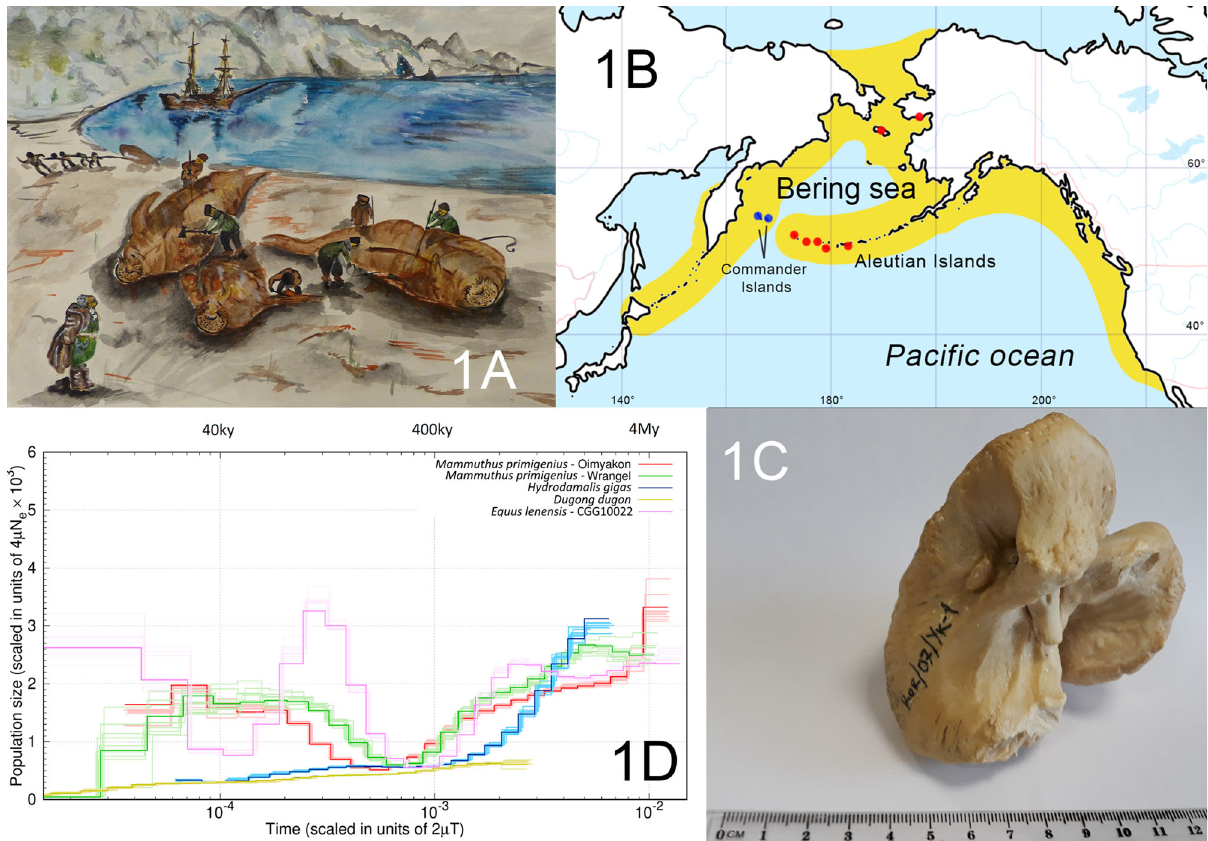
Fig. 1 Genome sequencing of the extinct Steller ’ s sea cow. A Reconstruction, aquarelle: The sailors of the Vitus Bering ’ s Great Northern Expedition (1741) cutting up the carcasses of killed Steller ’ s sea cows. Artist: Ekaterina Khritonenkova. B Geographical map of the Bering Sea region showing the distribution range of Steller ’ s sea cow during the Late Pleistocene (yellow), the archeological sites and localities (red circles) where samples of Steller ’ s sea cow were described, and the distribution of the last H. gigas population (blue circles). C The Hydrodamalis gigas petrous bone that was used for historical DNA extraction. D Steller ’ s sea cow, dugong, woolly mammoths, and Lena horse population size histories inferred using the Pairwise Sequentially Markovian Coalescent (PSMC) model. Population size history of each species marked by different color. Time is given in units of divergence per base pair on the X - axis, effective population size is shown on the Y -axis. Ky — means thousand years ago. My — means million years